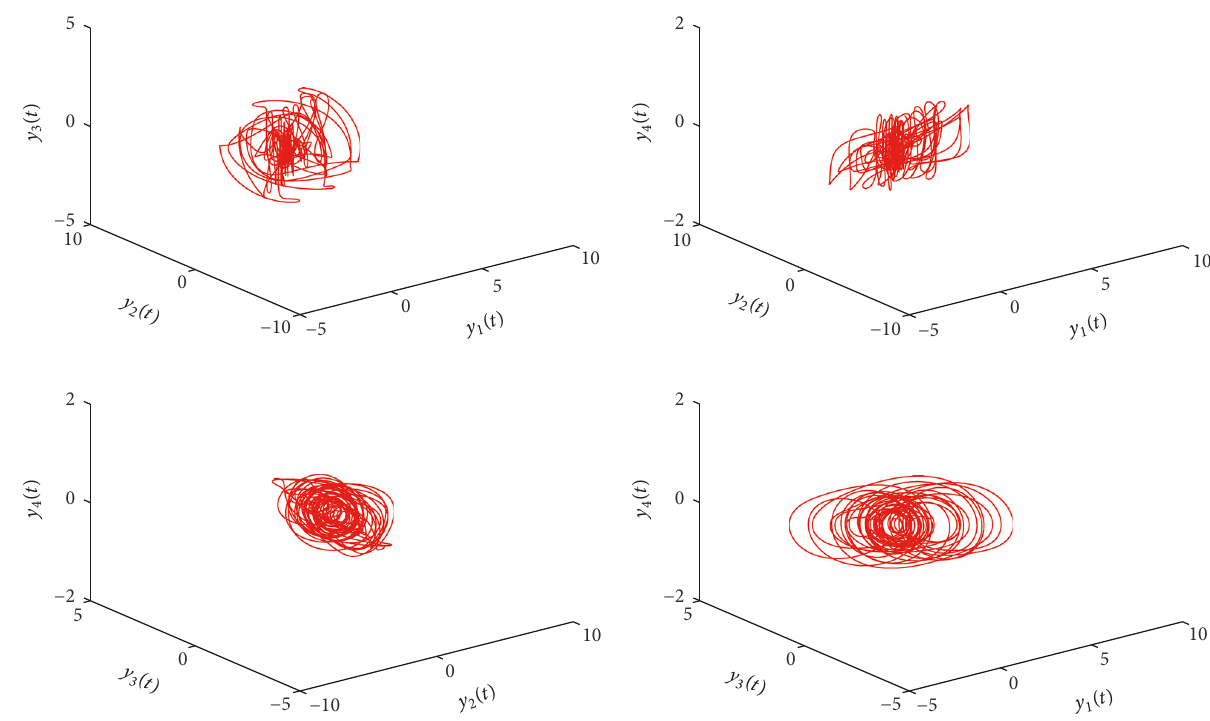
Figure 5: 3D phase portraits of the hyperchaotic Zhang-Shen